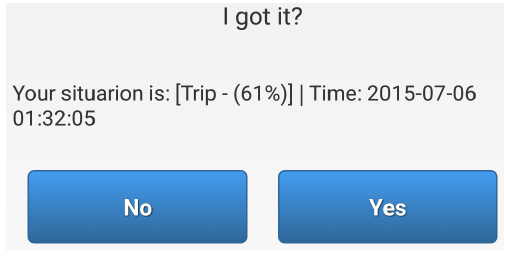
Figure 9. SituMan mobile GUI for requesting confirmations from participants.